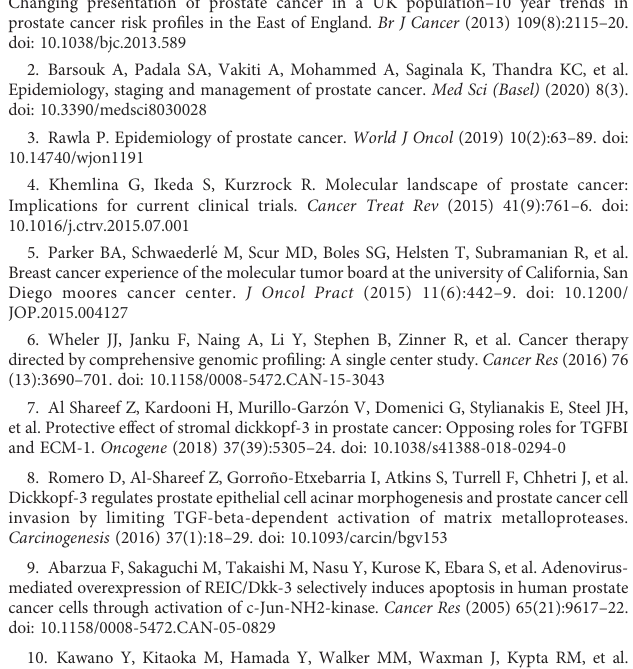
SUPPLEMENTARY TABLE 1 RNASeq data of cell lines as well as patient cohorts with the respective adj- p - value and fold changes for each gene in each